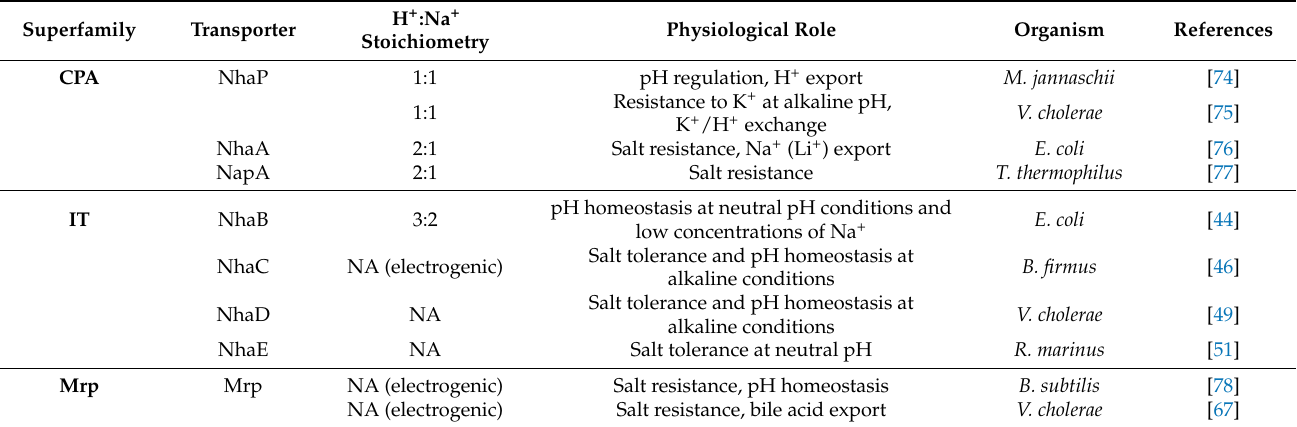
Table 1. Physiological role of some prokaryotic Na + /H + exchangers from different families. NA denotes an unknown